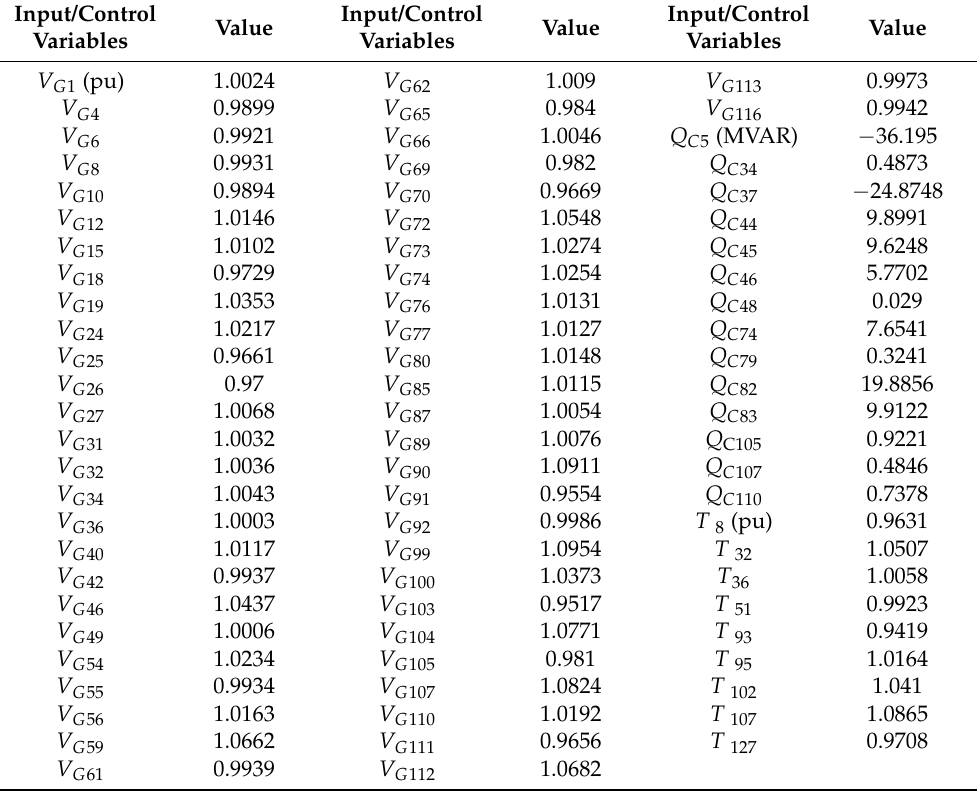
Table A4. Optimal solution obtained by ICOA for TVD objective of the IEEE 118-bus power system with the case of continuous variables.